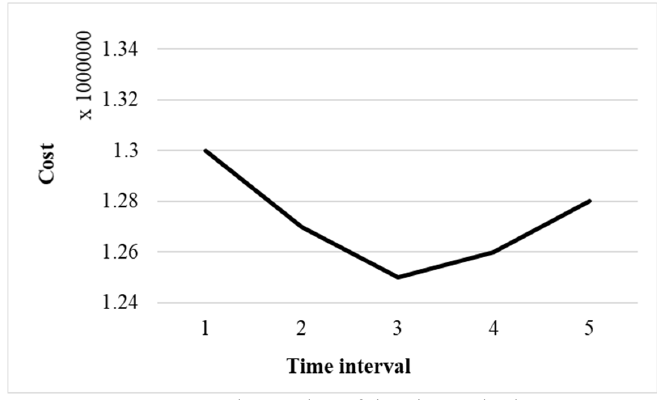
Fig. 3. Cost as the number of time intervals